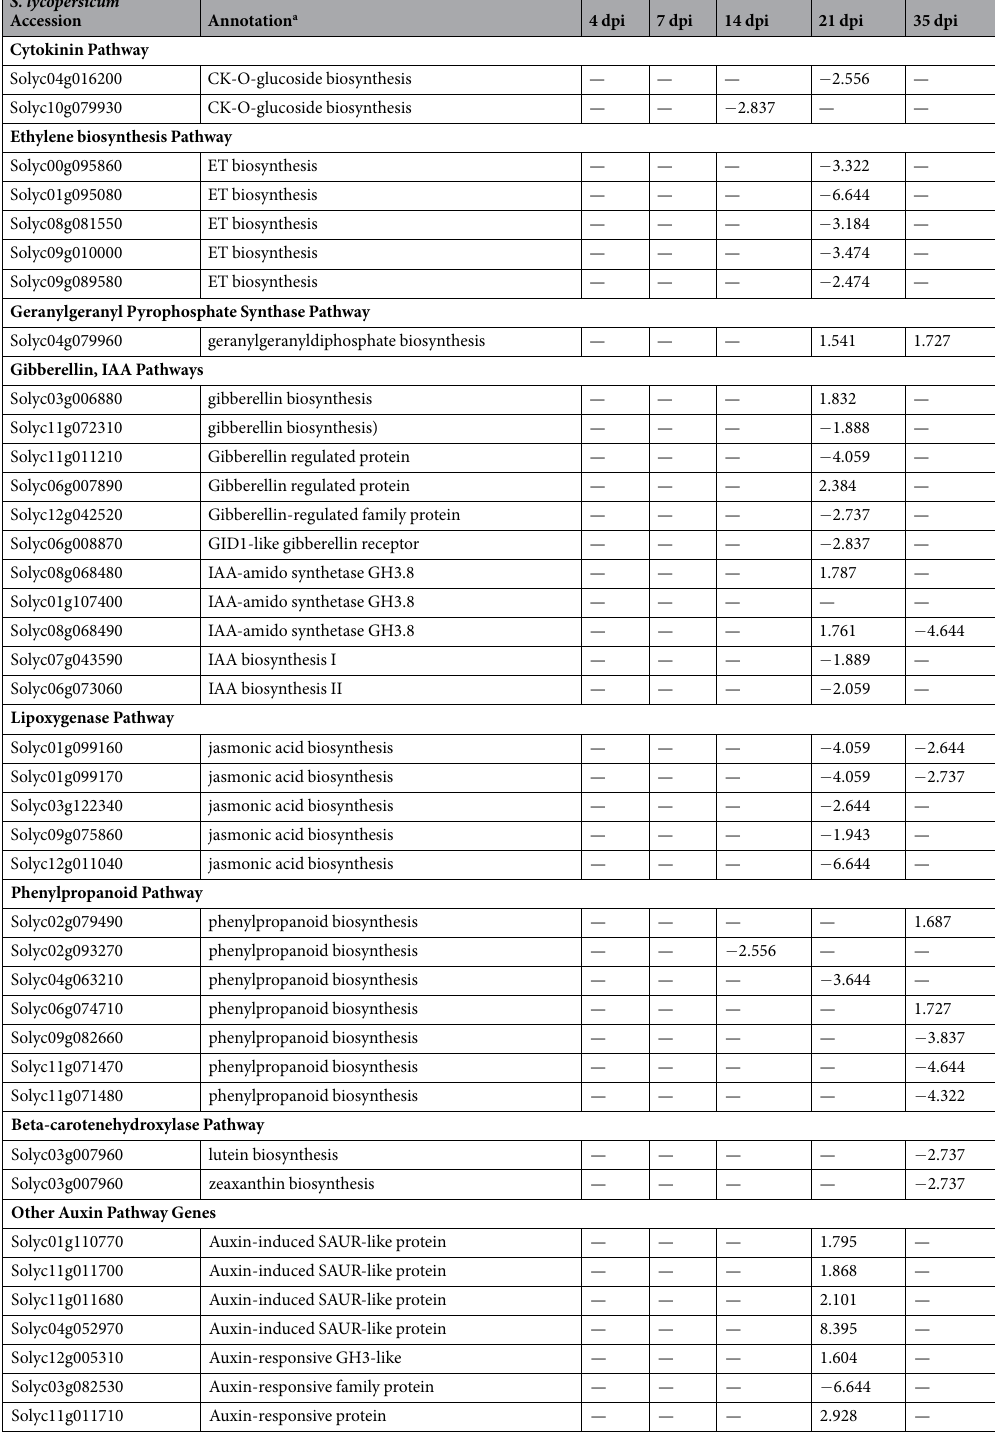
Table 4. Selected differentially expressed phytohormone-related genes in Sw-7 compared to the S-line after TSWV inoculation. a CK-Cytokinin, ET-stands for